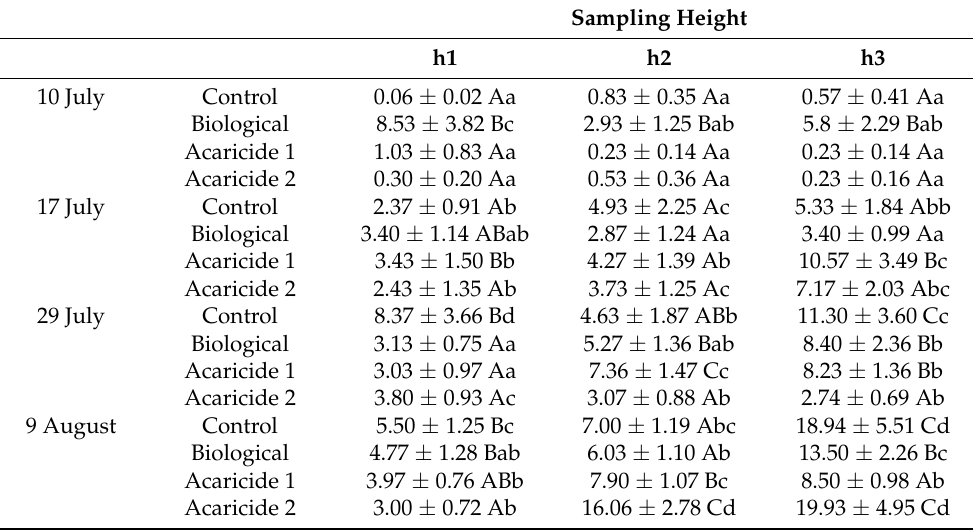
Figure 1. Average number of two-spotted spider mite eggs per leaf per treatment (for comparison between dates of evaluation within specific treatments (lowercase letters; df = 3, 359; for control treatment, F = 6.66, p < 0.05; for biological control treatment, F = 3.35, p < 0.05; for Acaricide 1, F = 4.20, p < 0.05; for Acaricide 2, F = 22.51, p < 0.05); for comparison between treatments on a specific date of evaluation (uppercase letters; df = 3,359; for 10 July, F = 9.23, p < 0.05; for 17 July, F = 1.35, p = 0.2580; for 29 July, F = 3.21, p < 0.05; for 9 August, F = 11, p < 0.05)). Table 4. Average number of two-spotted spider mite eggs per leaf according to different sampling